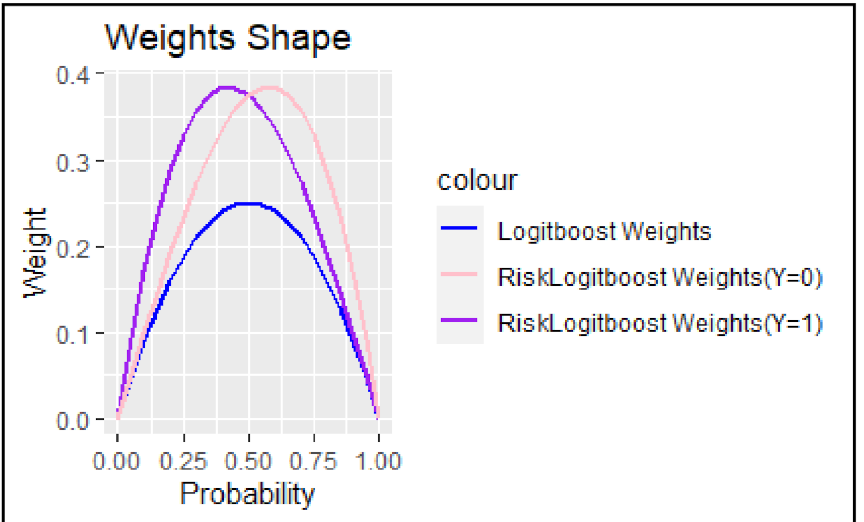
Figure 1. Plot of weights versus estimated probabilities of the Logitboost and the RiskLogitboost re-